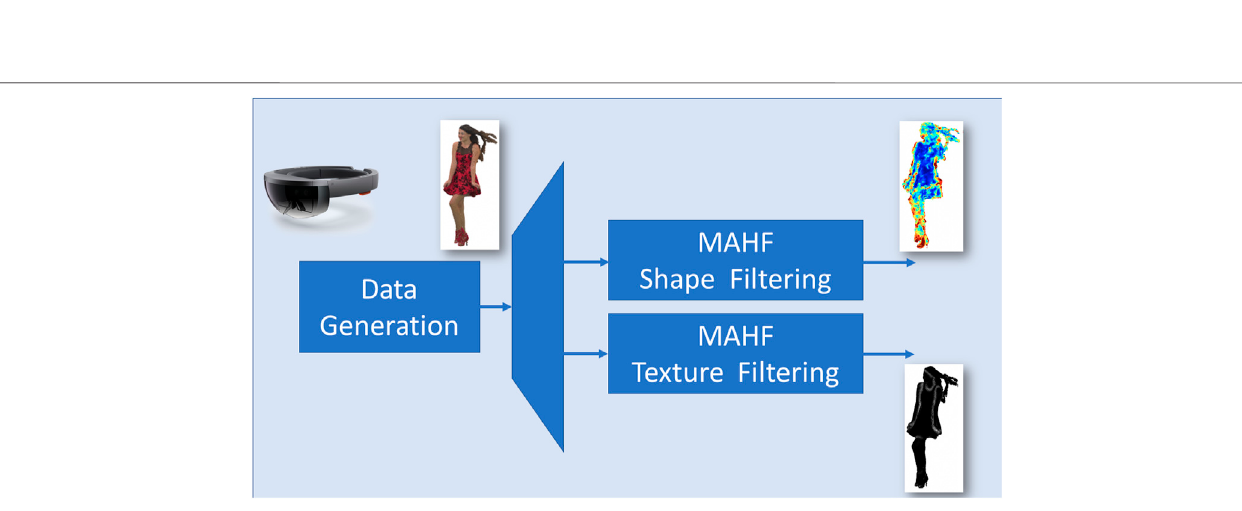
FIGURE 3 | Application of MAHF to texture (luminance) and shape (point cloud normals).